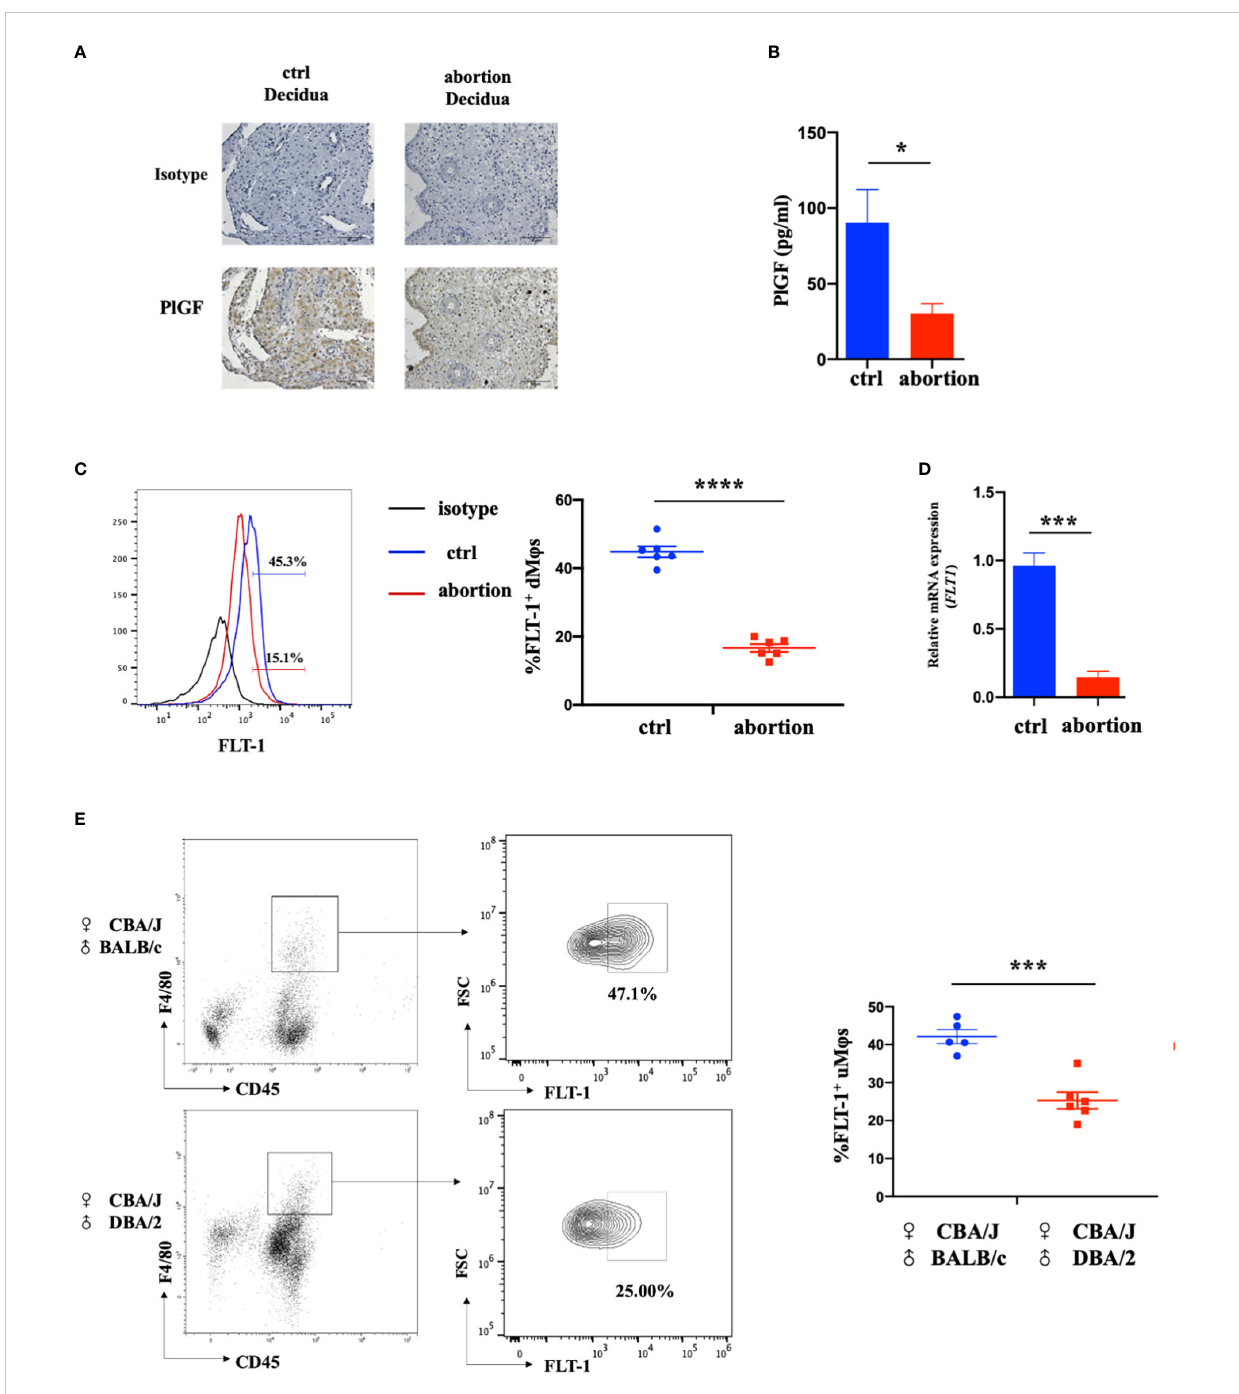
FIGURE 1 The expression of DSC-derived PlGF and its receptor FLT-1 in the early decidua. (A) Immunohistochemistry analysis of PlGF expression in the decidua from normal pregnancy (ctrl) and spontaneous abortion (n=3). Original magni fi cation: ×200. (B) The level of PlGF secreted by DSCs (1×10 5 cells per well) from normal pregnancy (ctrl) and spontaneous abortion (n=8) by ELISA at 48 hours after culture. (C) Flow cytometry (FCM) analysis of FLT-1 expression in decidual macrophages (dM j s) from normal pregnancy (ctrl) (n=6) and spontaneous abortion (n=6). (D) The qRT-PCR analysis of FLT-1 expression in dM j s from normal pregnancy (ctrl, n=4) and spontaneous abortion (n=4). (E) FCM analysis of FLT-1 expression on uterine macrophages (uM j s) from CBA/J×BALB/c control pregnant mice (n=5) and CBA/J×DBA/2 abortion-prone mice (n=6) in the fi rst trimester. Data were analyzed by Student ’ s t-test and shown as mean ± SEM. * P < 0.05, *** P < 0.001, and **** P < 0.0001. Ctrl,